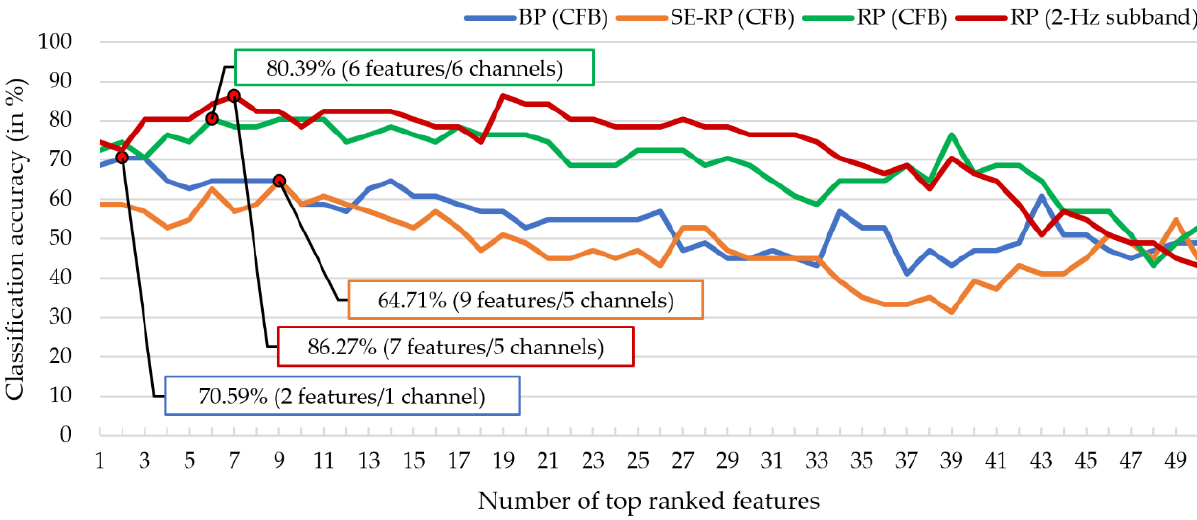
Figure 4. Comparison of MCI-HC classification accuracy among conventional frequency band (CFB)-based BP, SE-RP (CFB), RP (CFB), and 2-Hz-width subband-based RP based on the LDA classifier. The total numbers of feature candidates for the four features are 150, 150, 2175, and 9135, respectively. The best classification accuracies for the four features are 70.59%, 64.71%, 80.39%, and 86.27%, respectively. In terms of RP (2-Hz subband), its accuracy curve reached the maximum 86.27% when the number of top-F-score-ranked-feature increased to 7, which occupy only a very small portion of the whole RP feature candidates (7/9135 = 0.07%).